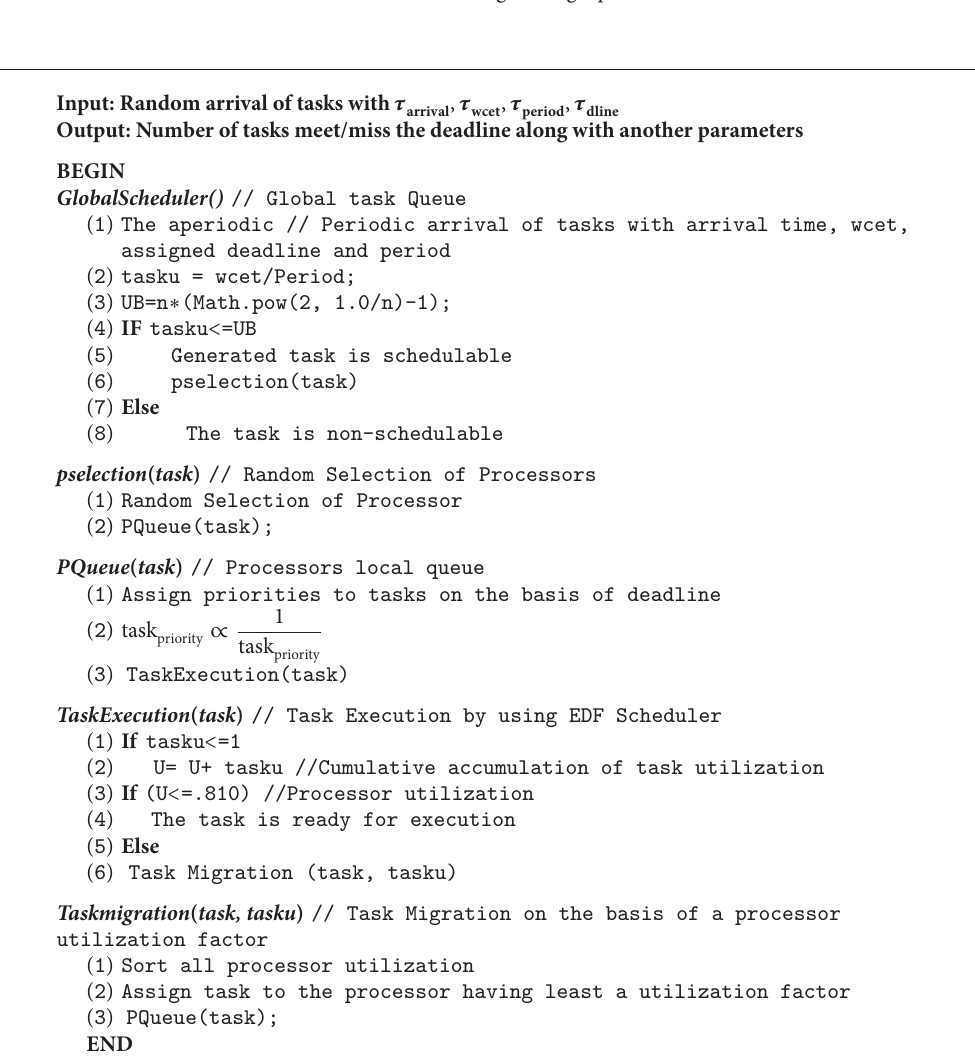
Algorithm 3: Joint EDF-RM scheduling